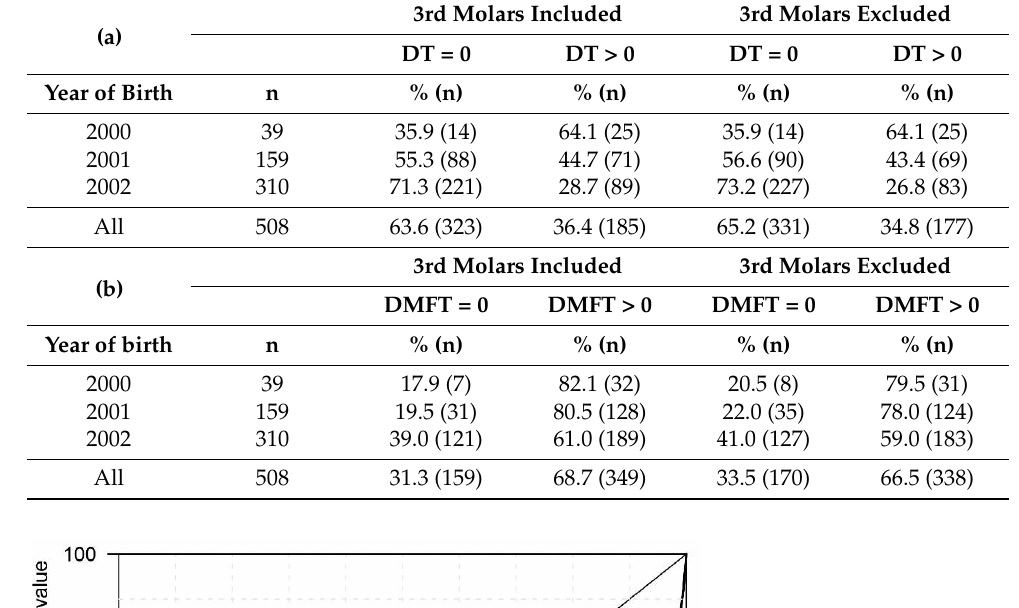
Table 3. Distribution of DT ( a ) and DMFT ( b ) values with and without third molars.